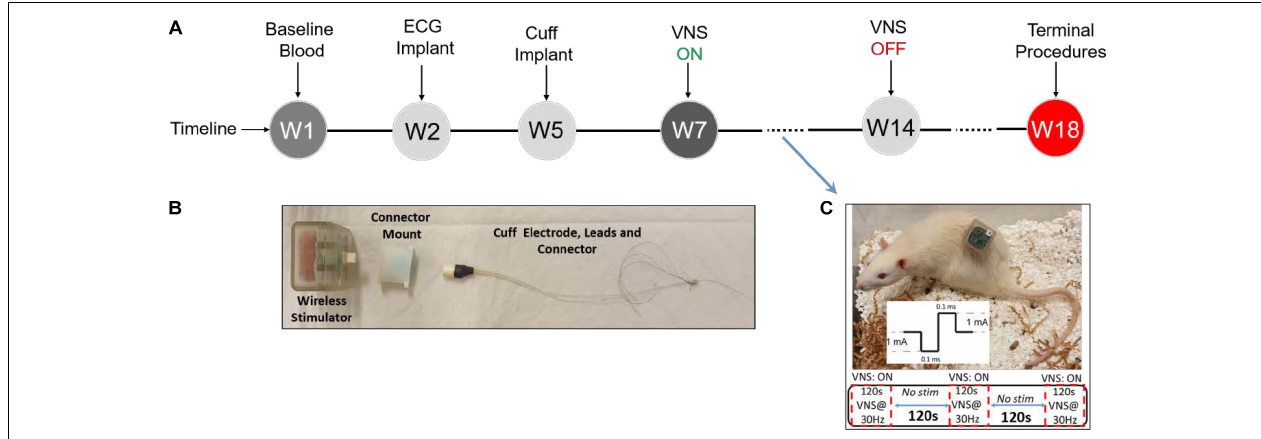
FIGURE 1 | Experimental design. (A) Experimental timeline. (B) Vagus nerve cuff electrode, connector mount (prototype), and wireless stimulator. (C) Wireless stimulator connected to an awake behaving rat during experiment, along with VNS parameters.